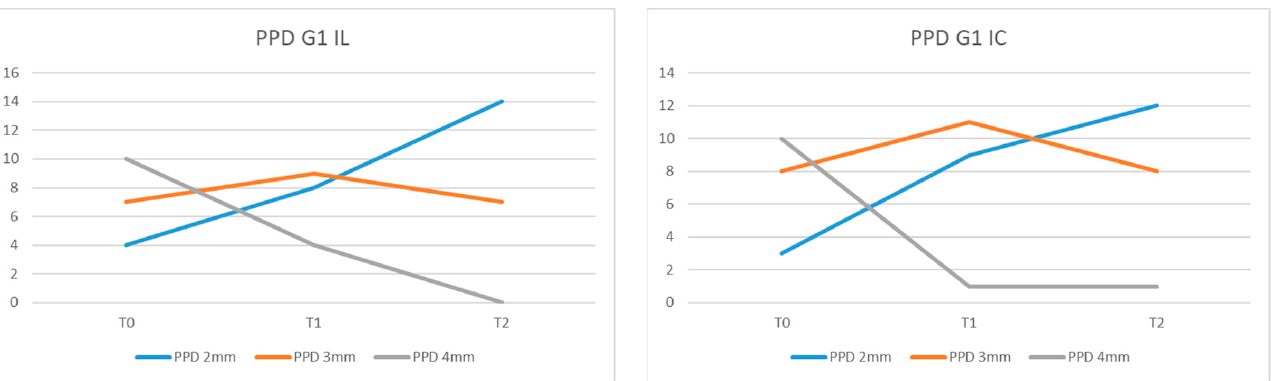
Figure 3. PI values in G2 at moments T0 and T2. When comparing the average values of the plaque index between G1 and G2 at moment T2, a statistically significant reduction ( p = 0.0311) was observed in patients from group G1.